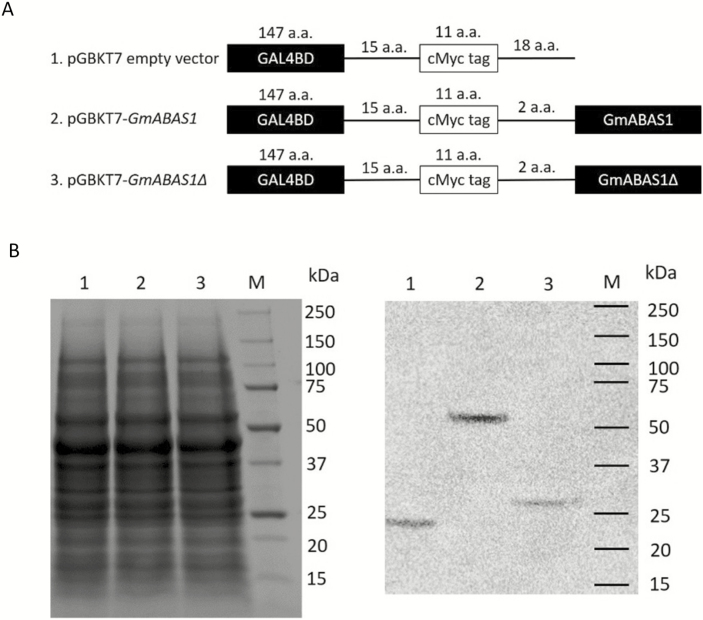
Size determination of the translation products of GmABAS1 and GmABAS1∆. (A) Schematics of the plasmid constructs for transformation into the yeast strain Y2HGold. (B) Total proteins from the transgenic yeast strains on SDS–PAGE. (C) Western blot detected by anti-cMyc antibodies. 1, pGBKT7 empty vector; 2, pGBKT7-GmABAS1; 3, pGBKT7-GmABAS1∆; M, molecular weight markers.